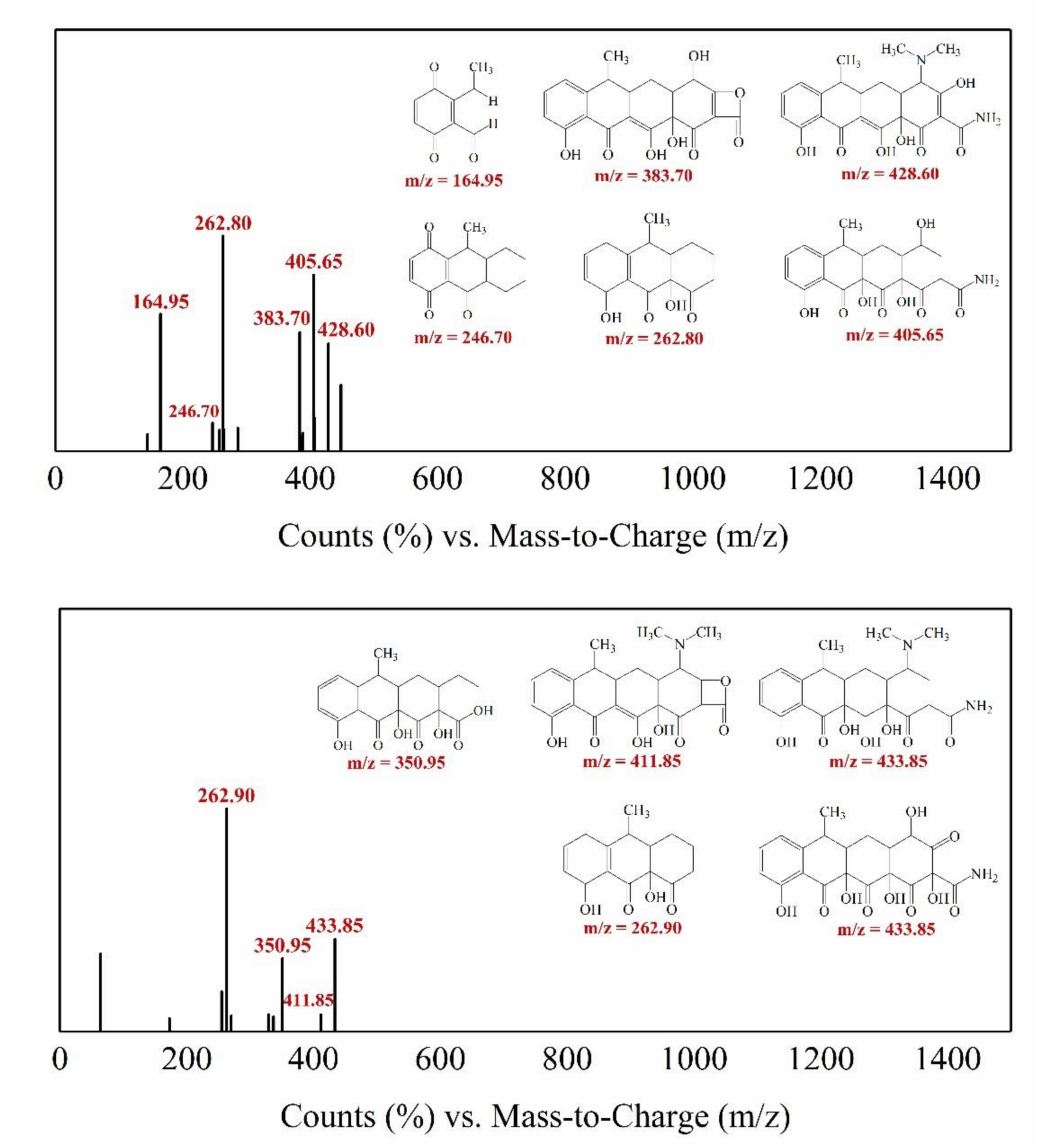
Figure 7. Degradation of tetracycline after a reaction time of 90 min in aqueous media was monitored by total ion chromatography using HPLC-MS. The inset shows the mass spectra of the eluted products at 1.782 min, 1.890